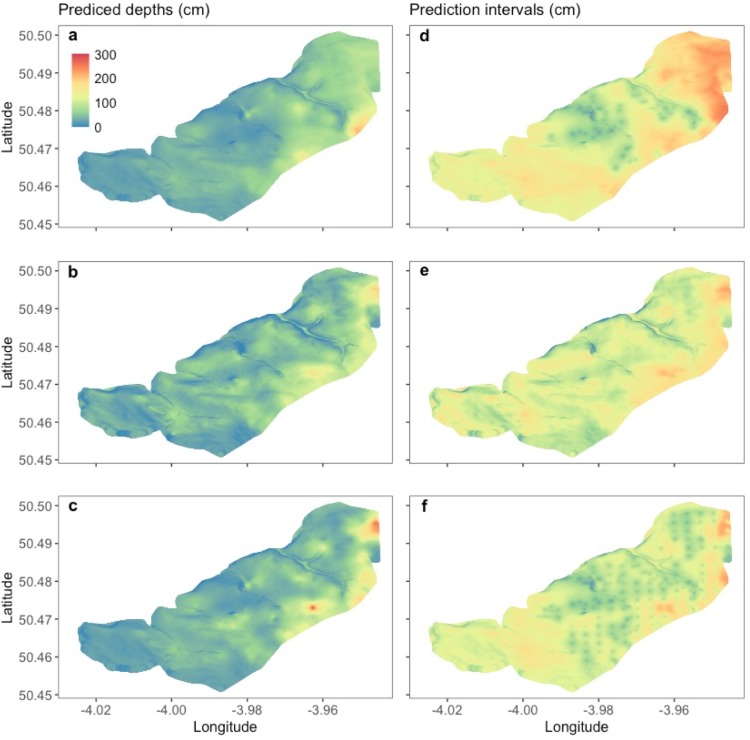
Predicted peat depth for unmeasured locations using the spatial model.(a) Using stratified sampling approach (PR-ST), (b) using gridded sampling approach (PR-GR), and (c) using the combined values from (a) and (b) (PR-CMB). (d-f) 95% prediction interval widths corresponding to the adjacent left-hand side panel. The depth (cm) legend in panel (a) applies to all panels.